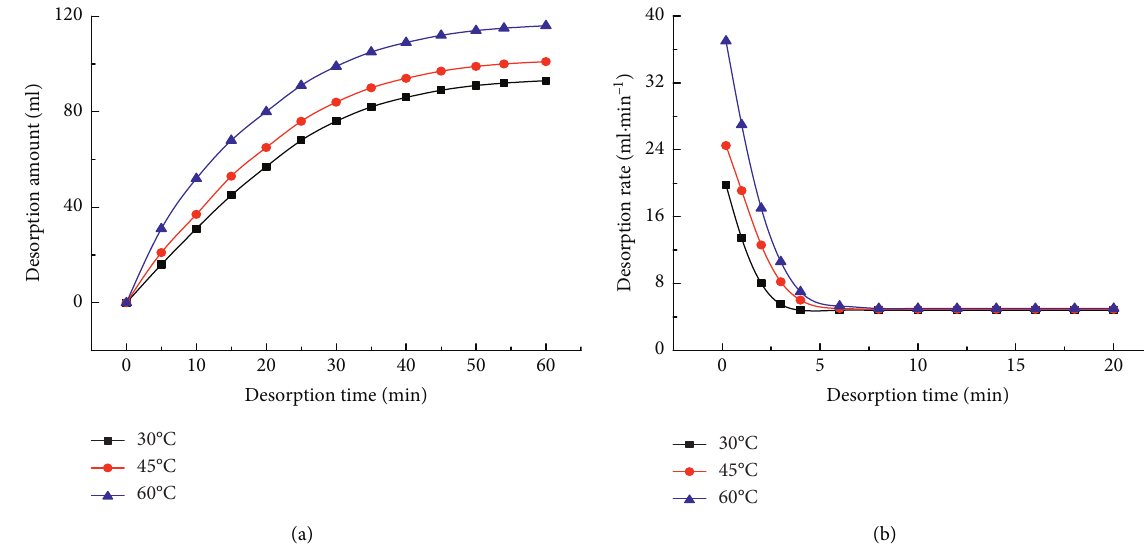
Figure 8: Desorption curve. (a) Desorption amount. (b) Desorption